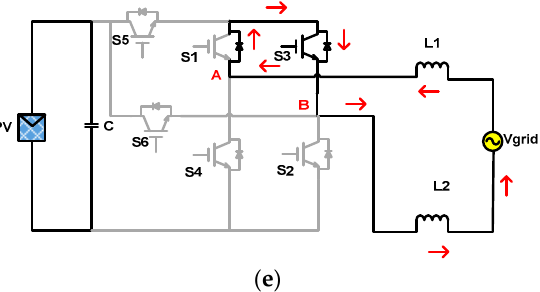
Figure 8. H6 II inverter and its operating modes. ( a ) H6 II inverter circuit, ( b ) current conduction during the positive half cycle of the grid voltage, ( c ) freewheeling mode during the positive half cycle of the grid voltage, ( d ) current conduction during the negative half cycle of the grid voltage and ( e ) freewheeling mode during the negative half cycle of the grid voltage.